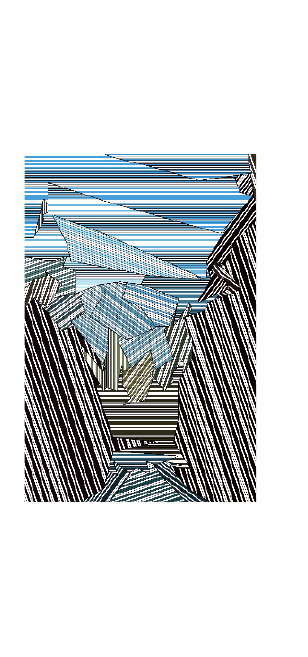
Figure 18. An illustration of extracting an erroneous secret message from the stego-image using an incorrect secret key “CÉZANNE”. ( a ) The stego-image with the stripe width of 6 pixels shown in Figure 14e. ( b ) The erroneous hidden data extraction result.